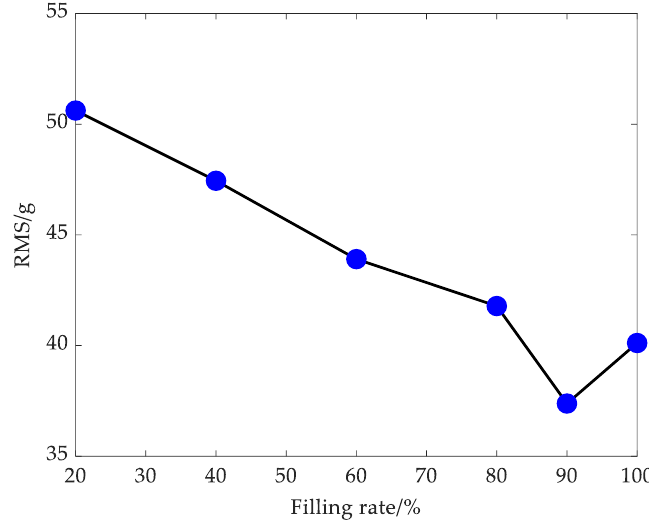
Figure 11. Influence of different filling rates on vibration reduction effect. Figure 11 indicates that the vibration reduction effect of the particle impact